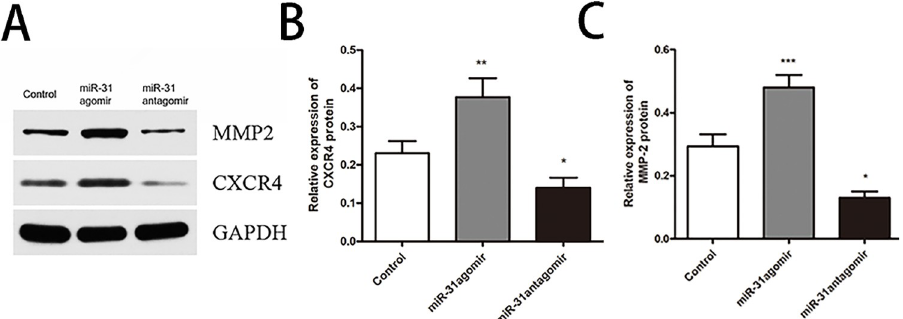
Fig 5. In vitro, miR-31 upregulated CXCR4 and MMP-2 expression. A Strip chart of protein expression. B The relative expression of CXCR4 protein in each group. C The relative expression of MMP-2 protein in each group. Dates are presented as mean ± SD (n = 3). Statistical analysis: compared to control, � P < 0.05, �� P < 0.01, ��� P <